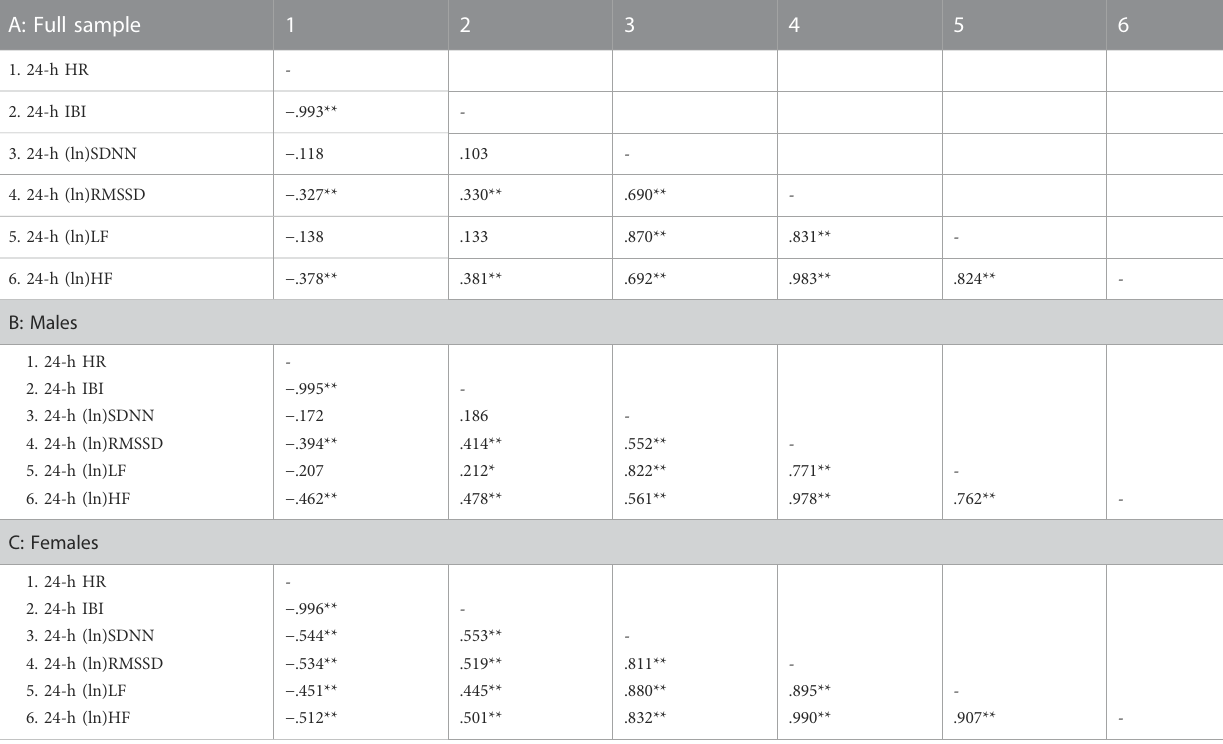
TABLE 2 Correlation coef fi cients in the full sample and strati fi ed by sex for 24-h values of cardiac chronotropy and heart rate variability. A: Full